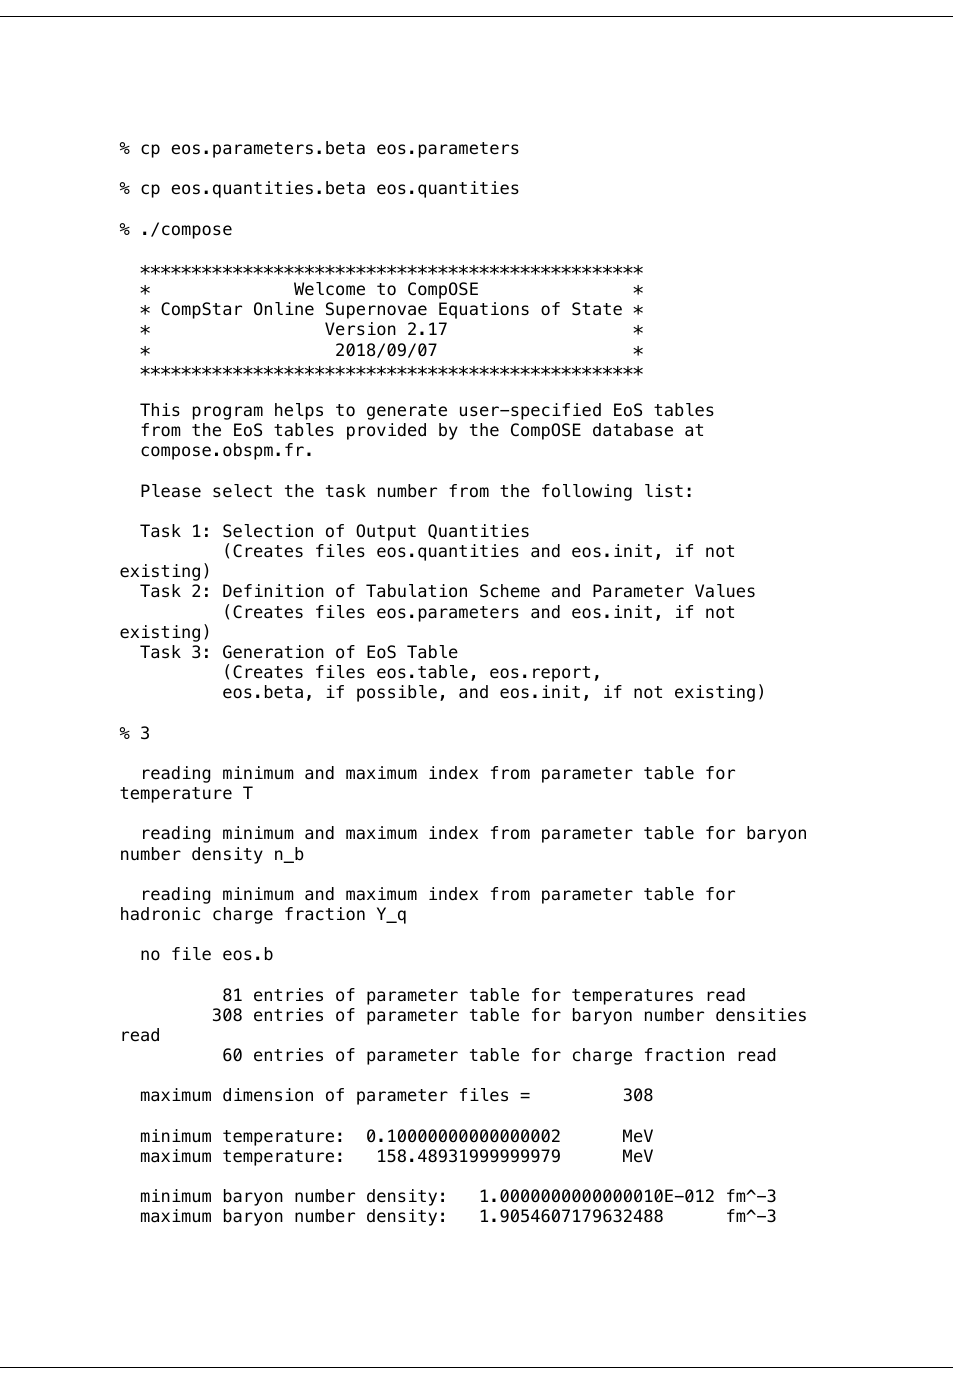
Figure A1. Snapshot when running compose for generating a table for β -equilibrated matter from a general purpose